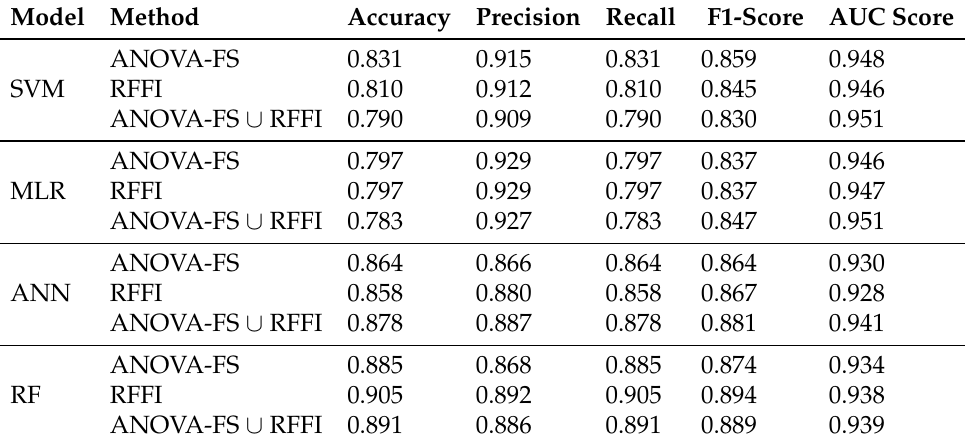
Table 2. Performance of the trained models when applied to the test